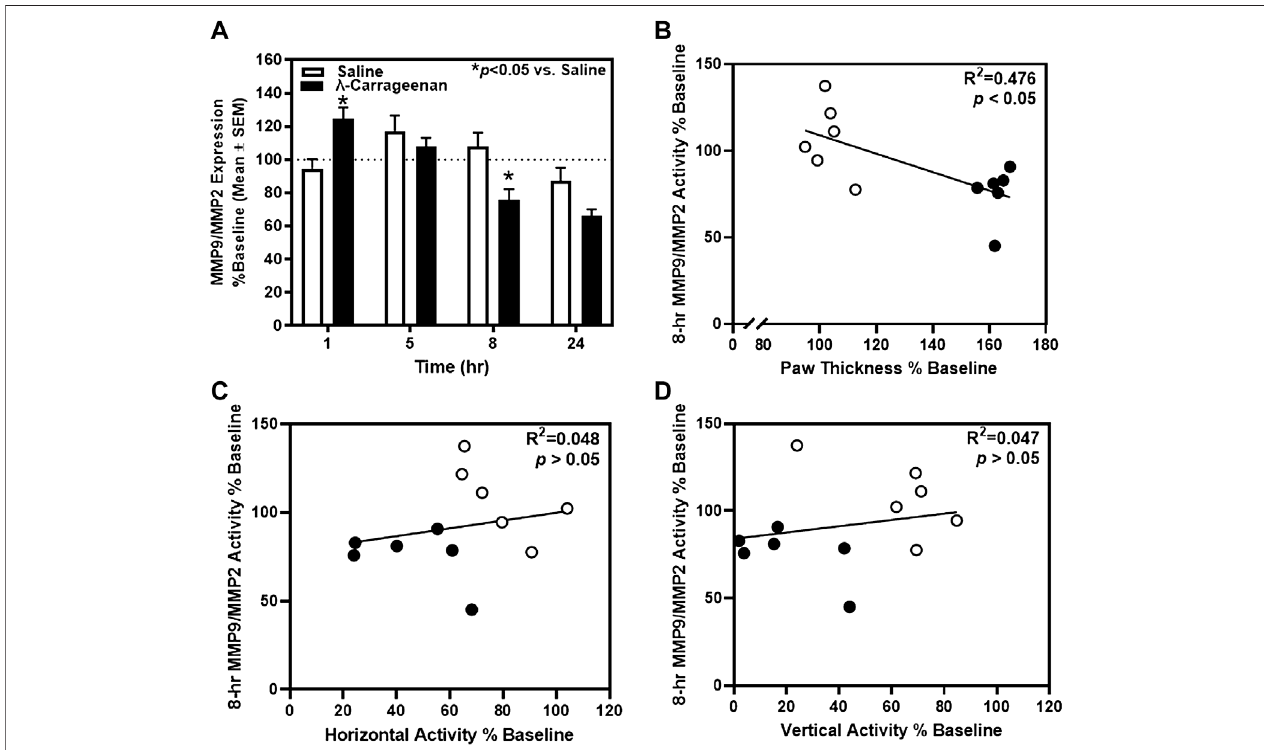
FIGURE 6 | The impact of λ -carrageenan on the timecourse of MMP9/MMP2 activity is presented with correlational analyses. The percent of baseline MMP9/ MMP2 activity was calculated as the mean value at each time point following treatment with saline (white bars) or λ -carrageenan (black bars), normalized to baseline values. (A) λ -Carrageenan signi fi cantly increased MMP9/MMP2 activity at the 1 h, and decreased MMP9/MMP2 activity, at the 8 h timepoint, respectively (* p < 0.05 vs. Saline). (B) MMP9/MMP2 activity negatively correlated with paw thickness at the 8 h timepoint. No signi fi cant correlation between MMP9/MMP2 activity and locomotor activity was detected (C,D)